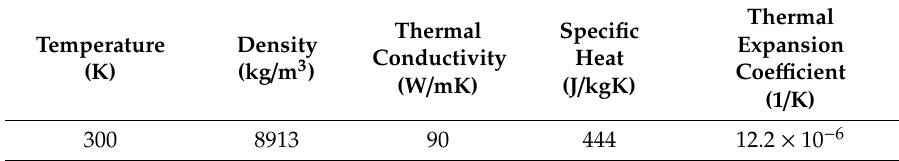
Table 8. Physical properties of the electrodeposited Nickel.